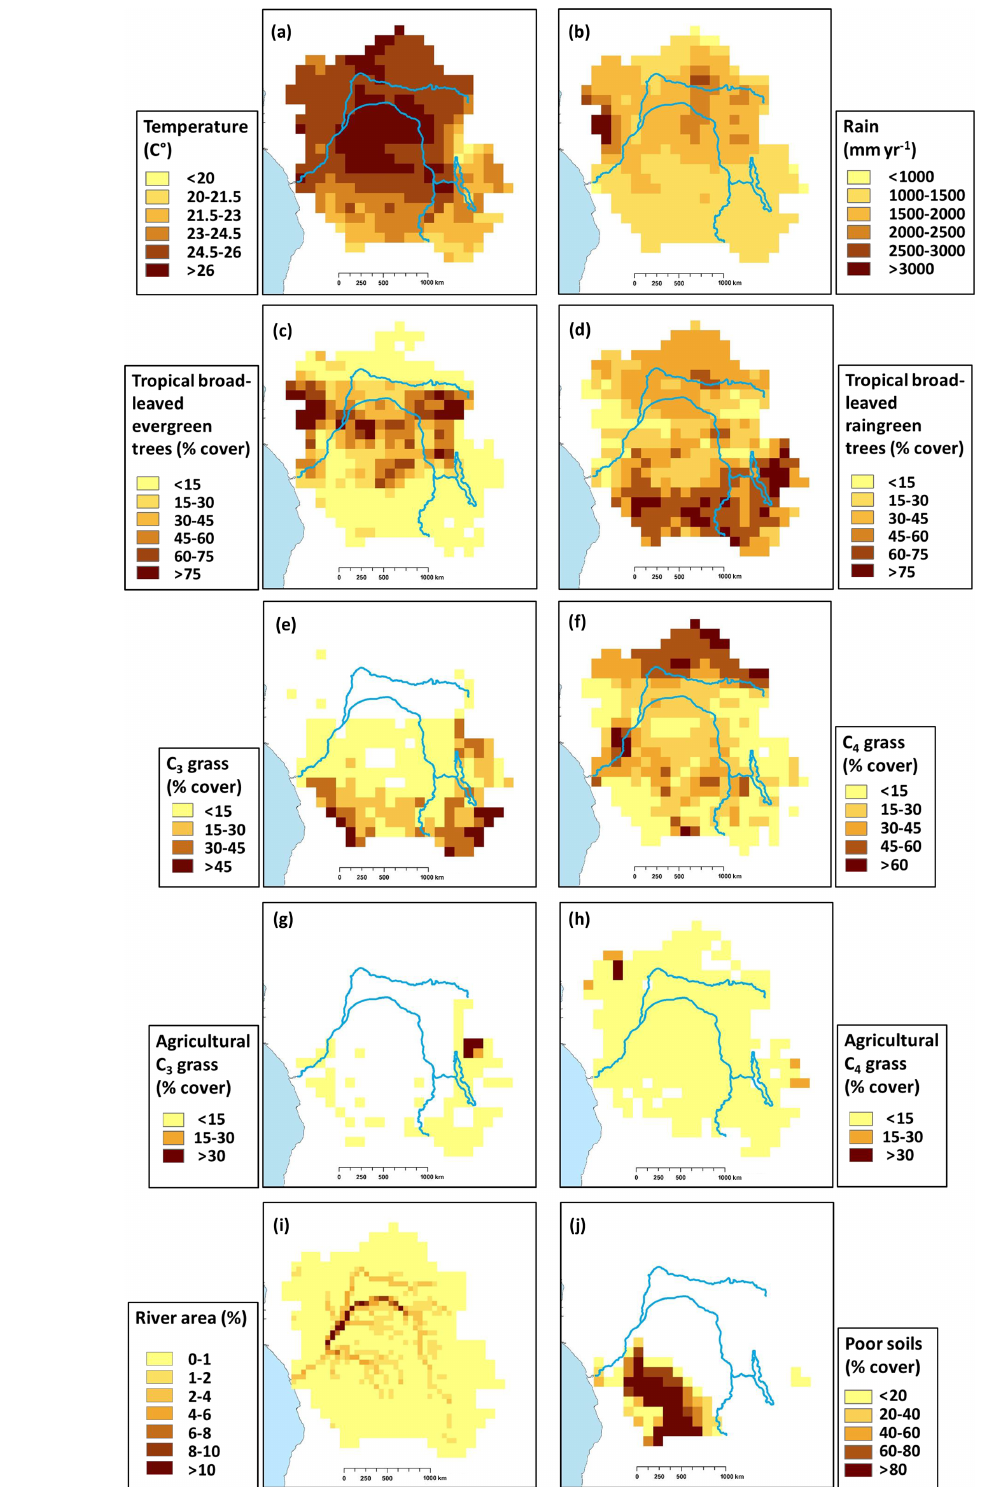
Figure 2. Present-day (1981–2010) spatial distribution of the principal climate and land use drivers used in ORCHILEAK across the Congo Basin; (a) mean annual temperature ( ◦ C), (b) mean annual rainfall (mmyr − 1 ), (c–h) mean annual maximum vegetated fraction for PFTs 2, 3, 10, 11, 12, and 13, respectively; (i) river area; and (j) poor soils. All are at a resolution of 1 ◦ except for river area (0.5 ◦ ).